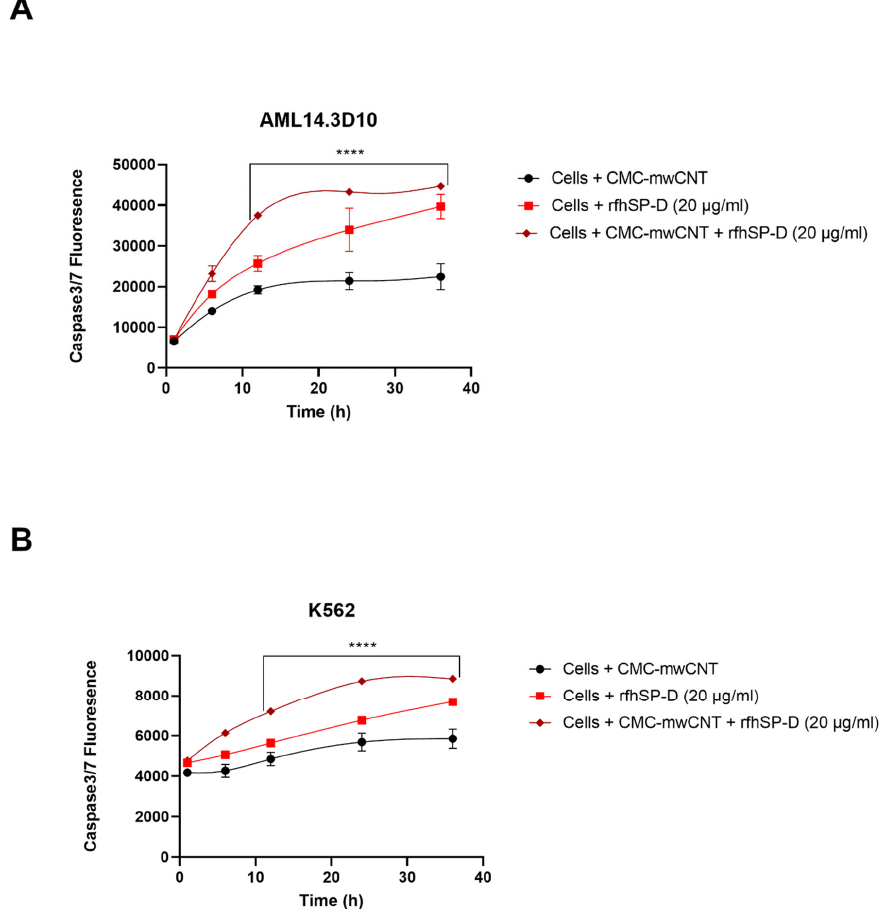
Figure 8. Activation of caspase 3/7 in AML14.3D10 ( A ) or K562 ( B ) cell lines following CNT + rfhSP-D treatment. AML14.3D10 or K562 cells (0.1 × 10 5 ) were seeded and challenged with CNT + rfhSP-D (20 µ g/mL) or rfhSP-D (20 µ g/mL) Cells + CNT was used as an untreated control. **** p < 0.0001 versus control group ( n = 3).